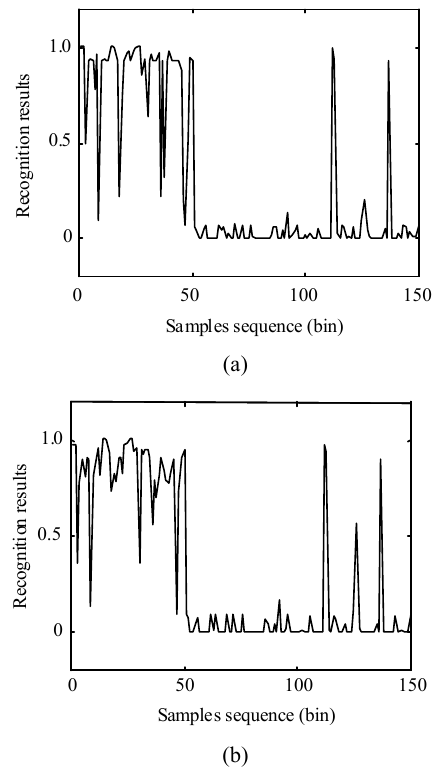
Fig. 8 Recognition result of RVFL NN: (a) classification results of running signals and (b) classification results of digging signals. Table 1 Recognition rate of RVFL